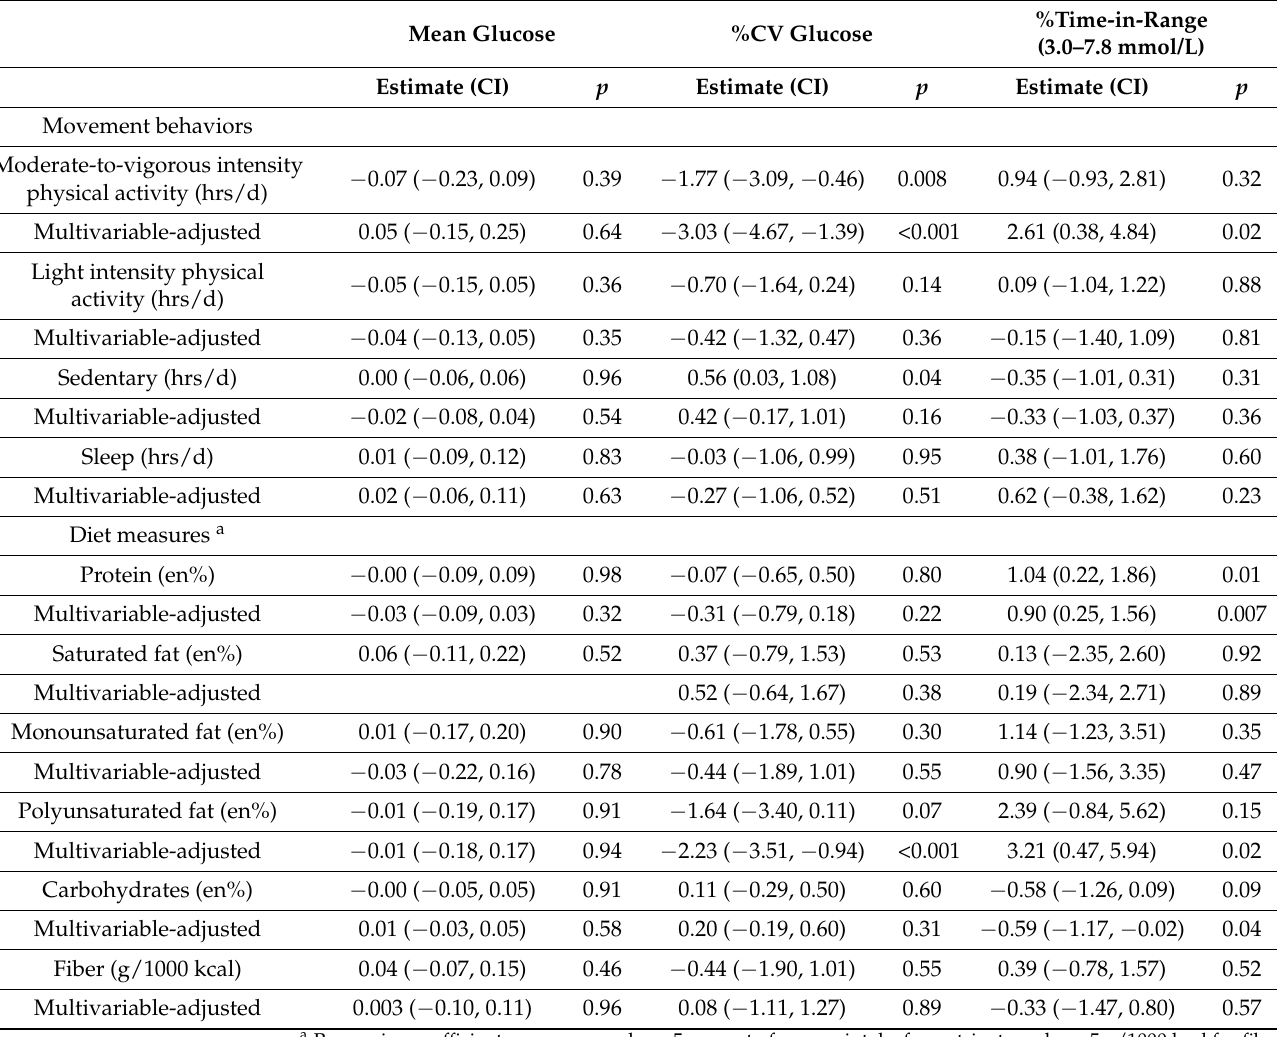
Table 3. Associations between movement behaviors, dietary intake, and glucose monitoring metrics over seven